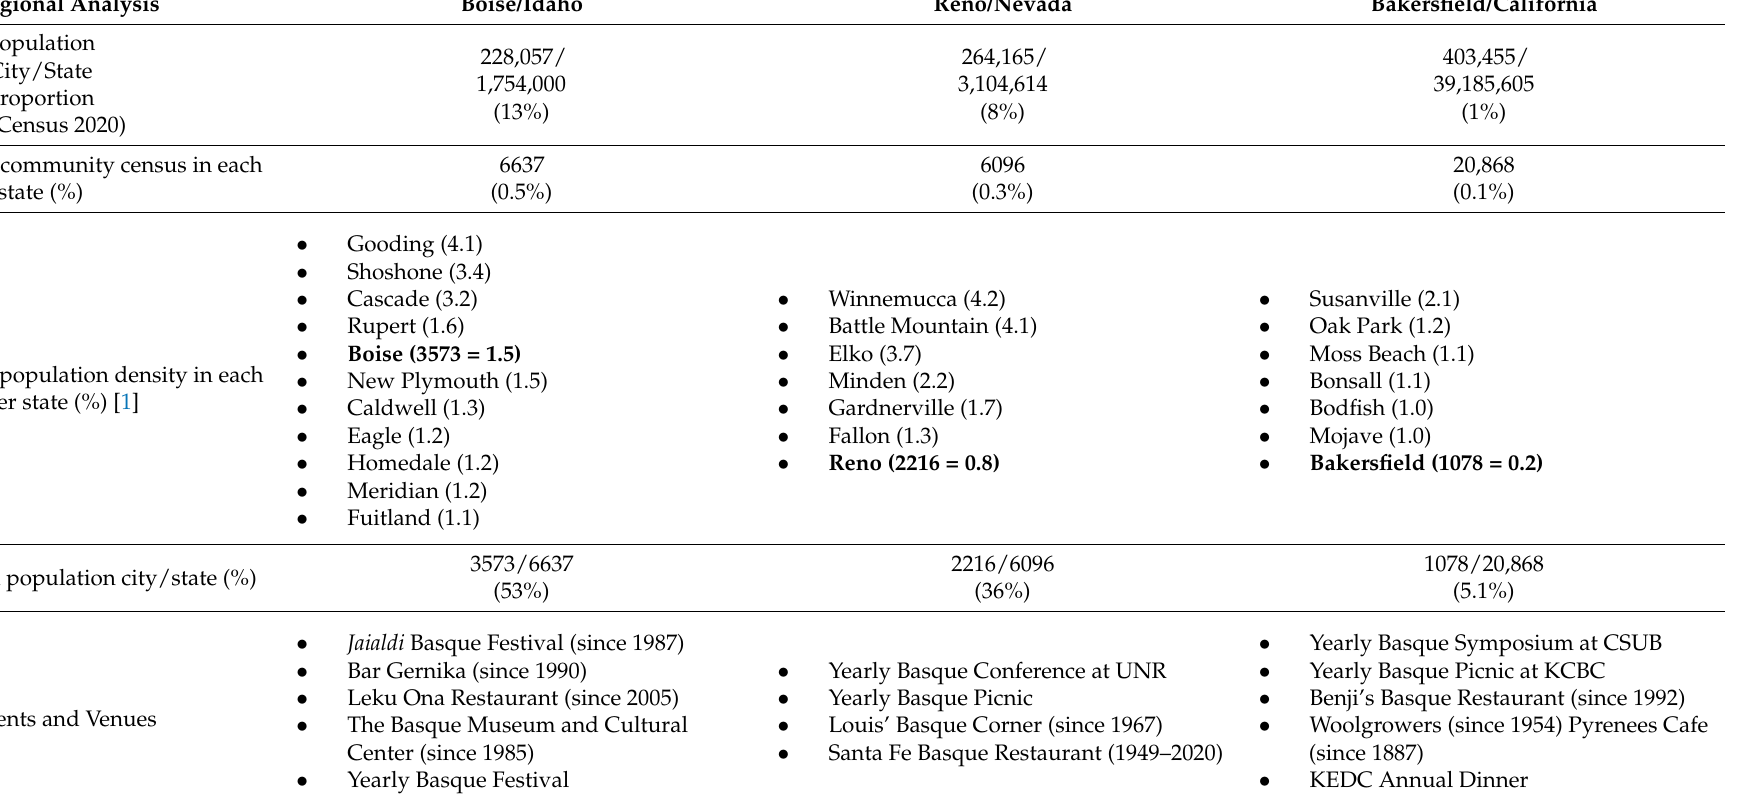
Table 1. Benchmarking Boise/Idaho, Reno/Nevada, and Bakersfield/California: City-regional and academic program analysis. City-Regional